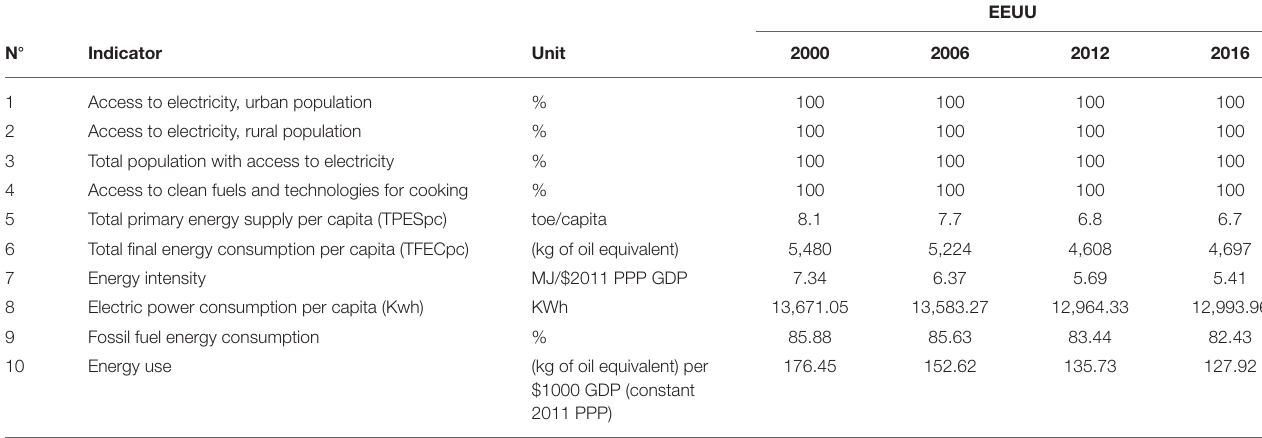
TABLE 4 | Energy indicators data – EEUU (2000, 2006, 2012,